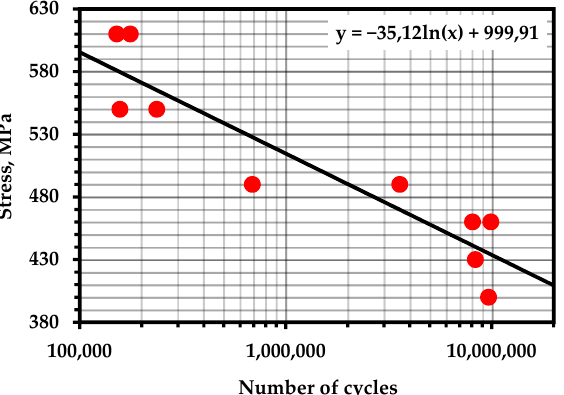
Figure A16. S–N Curve—Steel S355JR (accepted as an analogue) (Temperature—293 K; frequency— 30 Hz) [105].